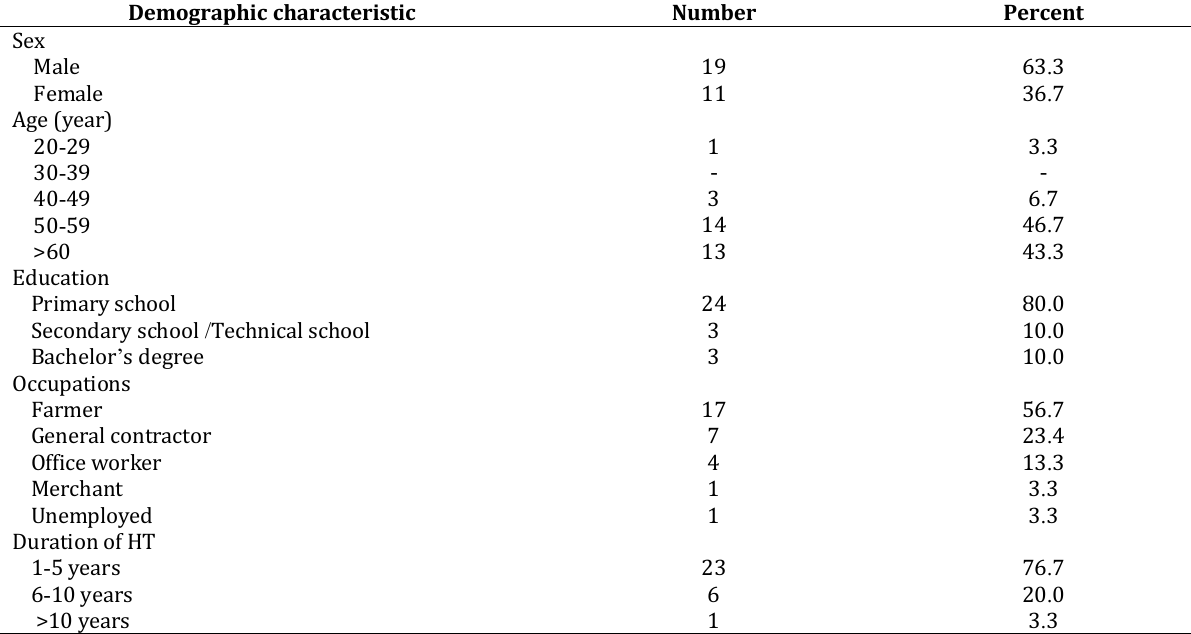
Table 1. Demographic Characteristic of Participants in Nurse - led Team - Based Hypertension Management Program